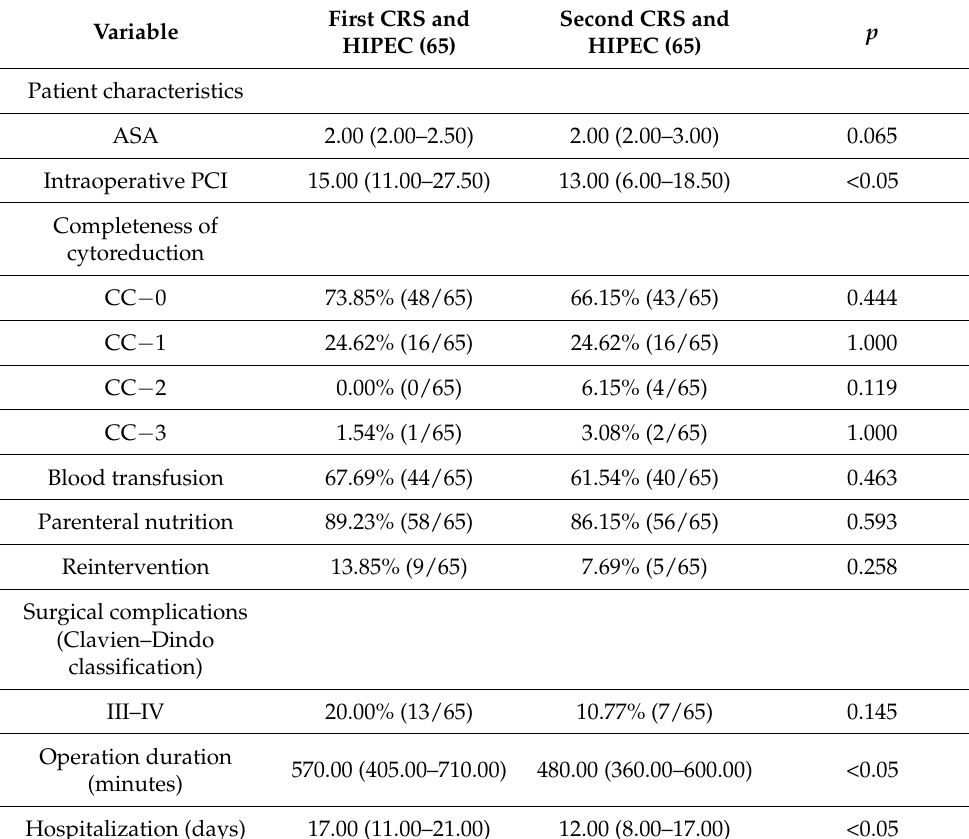
Table 2. First and second CRS and HIPEC characteristics and complications of patients who under- went at least two procedures. The p -values refer to the paired Wilcoxon test, chi-squared test, or Fisher’s exact